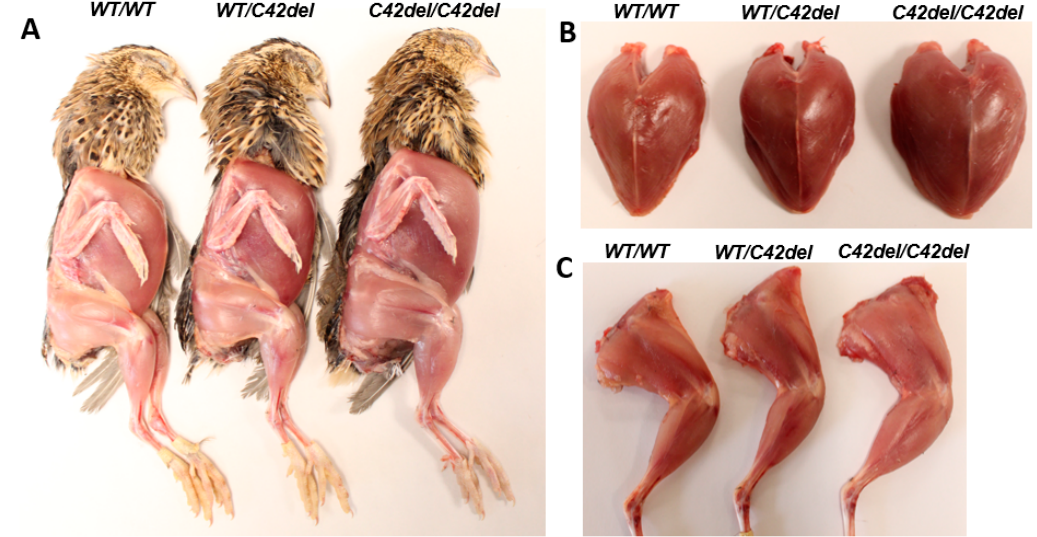
Figure 3. Phenotypic comparisons of whole body ( A ), breast muscle ( B ), and leg muscle ( C ) among groups in 6-week old female quail.